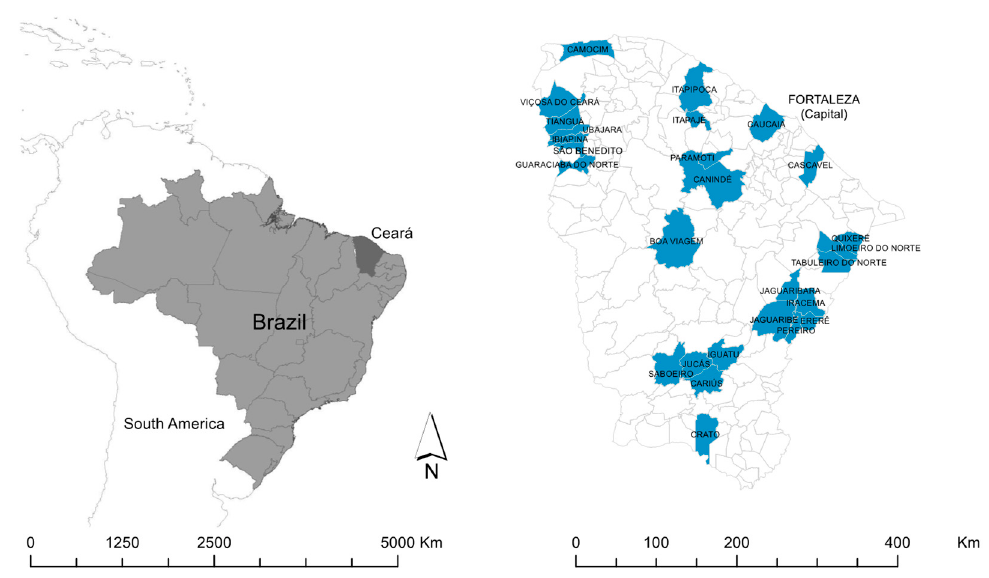
Figure 1. Location of Cear á State in Brazil, and location of the municipalities included in the